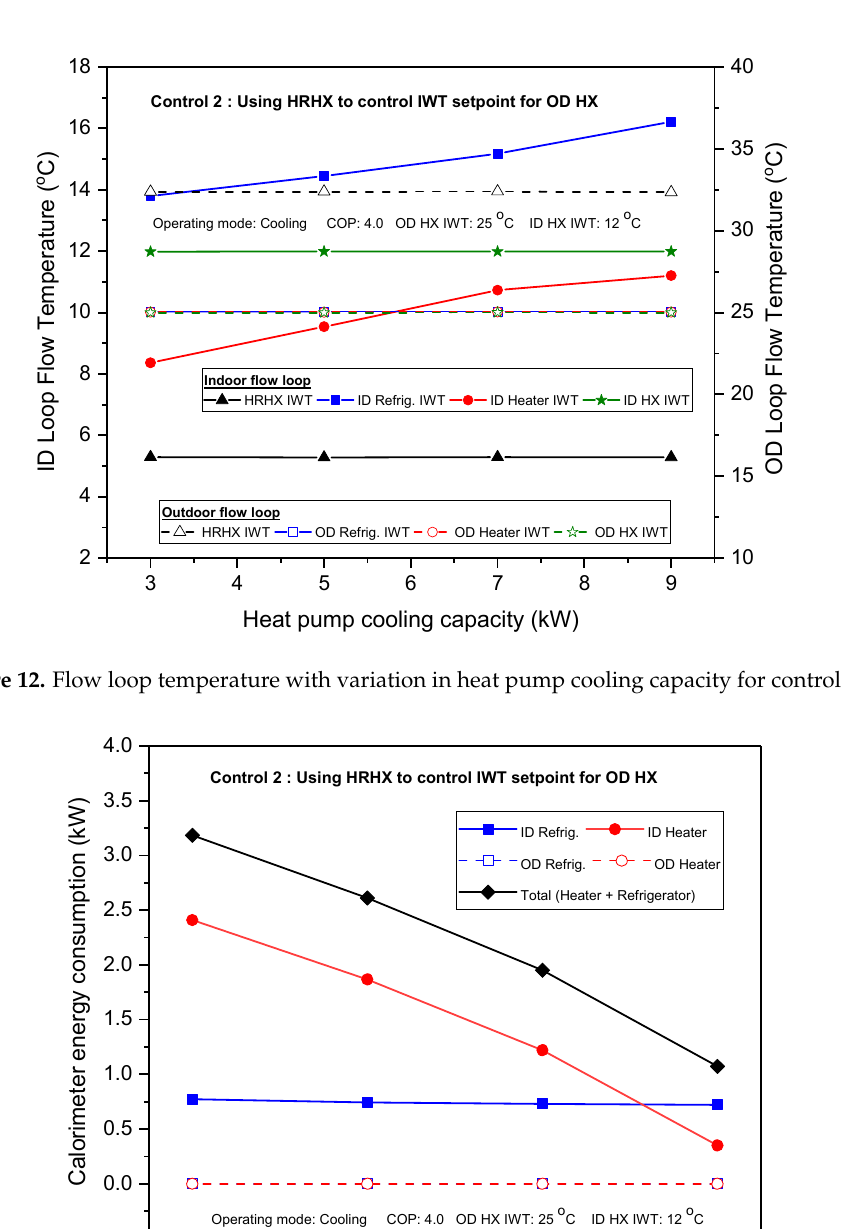
Figure 14. Total energy analysis for a conventional calorimeter and the heat recovery calorimeter in cooling mode. Also, in Figure 14, as the heat pump cooling capacity increased from 3 to 9 kW, the total energy utilization rate of the conventional calorimeter was about 71 to 92% higher than that of the calorimeter with heat recovery control methods. The reason for this is that the conventional